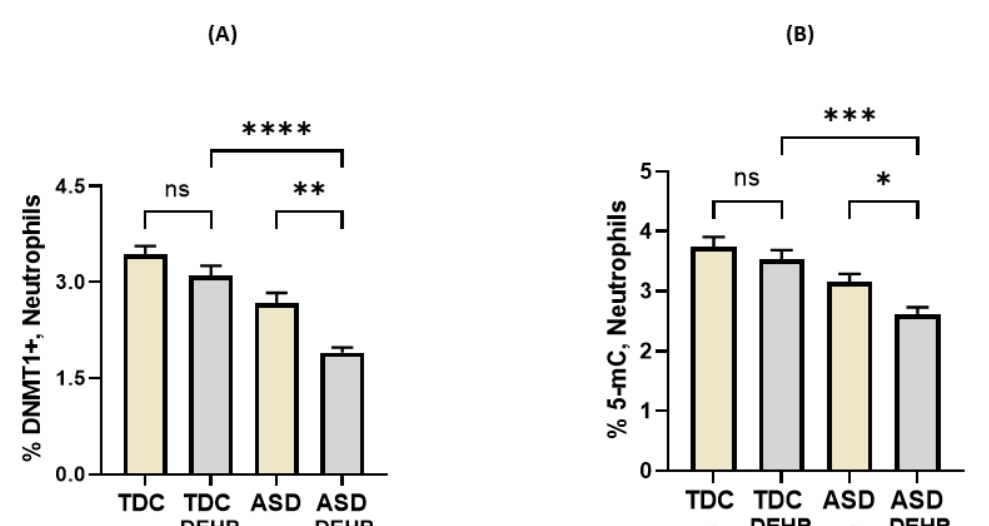
Figure 3. Effect of DEHP on DNMT1 expression and DNA methylation in neutrophils of ASD and TDC subjects. ( A ) Percentage of DNMT1 expression in neutrophils and ( B ) global DNA methylation levels in neutrophils. Values are presented as mean ± SEM, n = 15/group. * p < 0.05; ** p < 0.01; *** p < 0.001; **** p < 0.0001; ns = not significant.